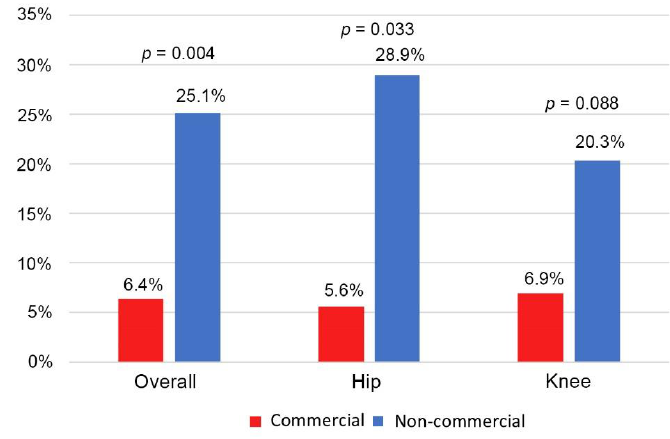
Figure 2. The spacer exchange rate between the hips and knees.